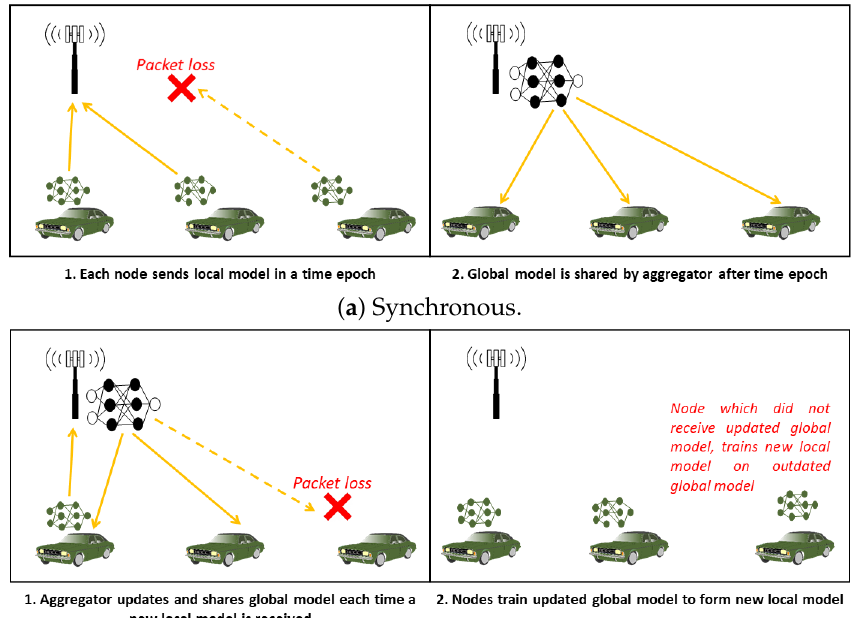
Figure 2. Modes of FL in